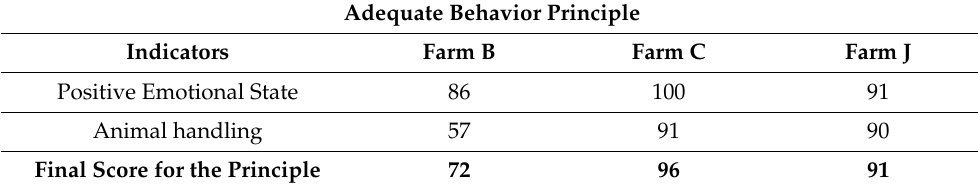
Table 4. Final score for the adequate behavior principle.